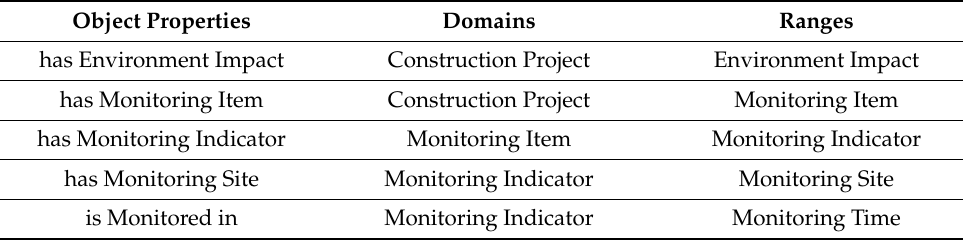
Table 2. Definition of object properties.